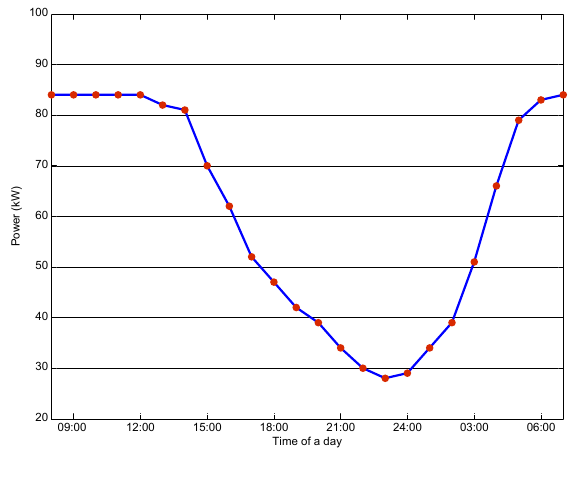
Figure 4. Hourly average office power demand of a day in the island.